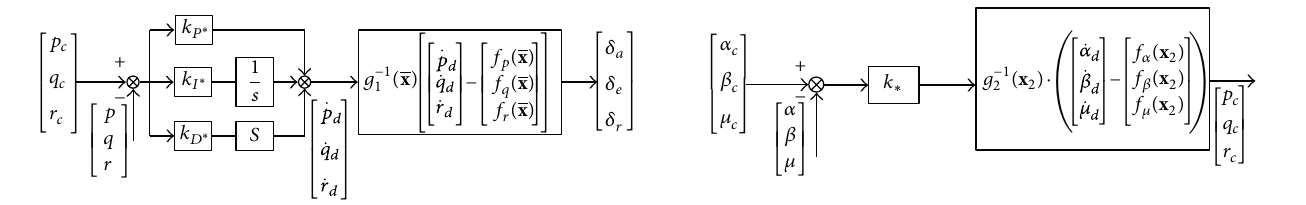
Figure 4: The control structure corresponding to the middle-speed